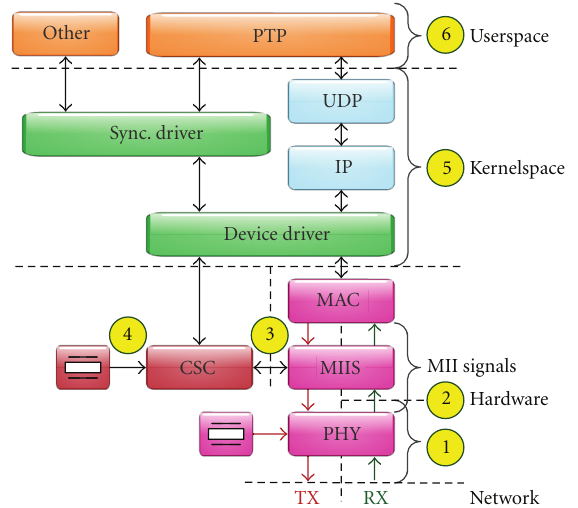
Figure 1: Synchronization node overview and possible internal sources of